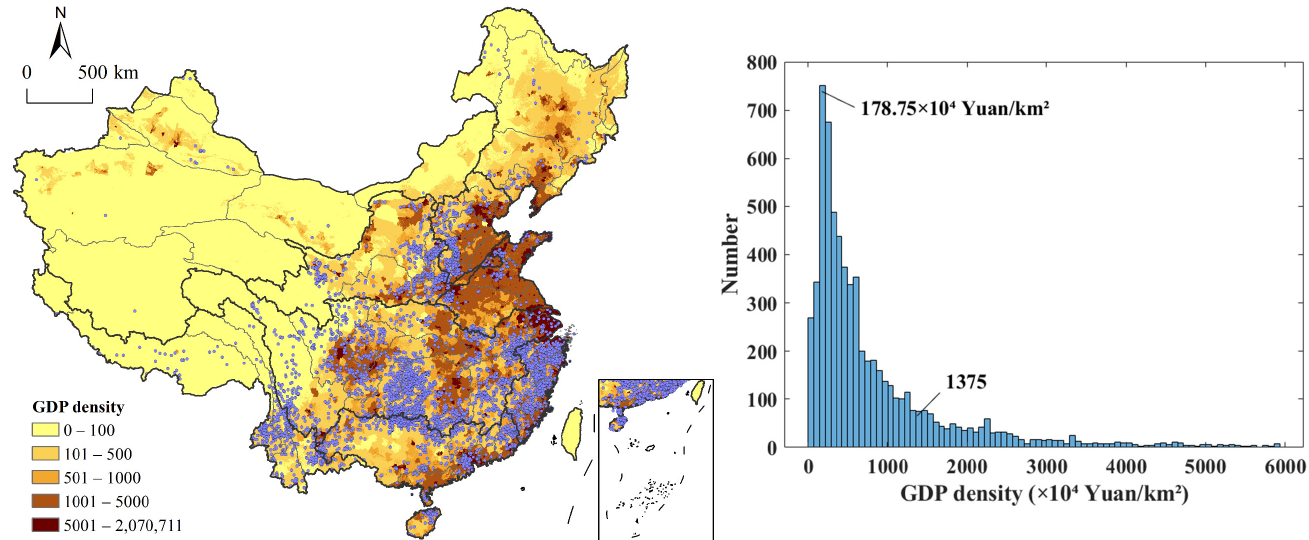
Figure 12. Relationships between traditional villages and GDP density in China.